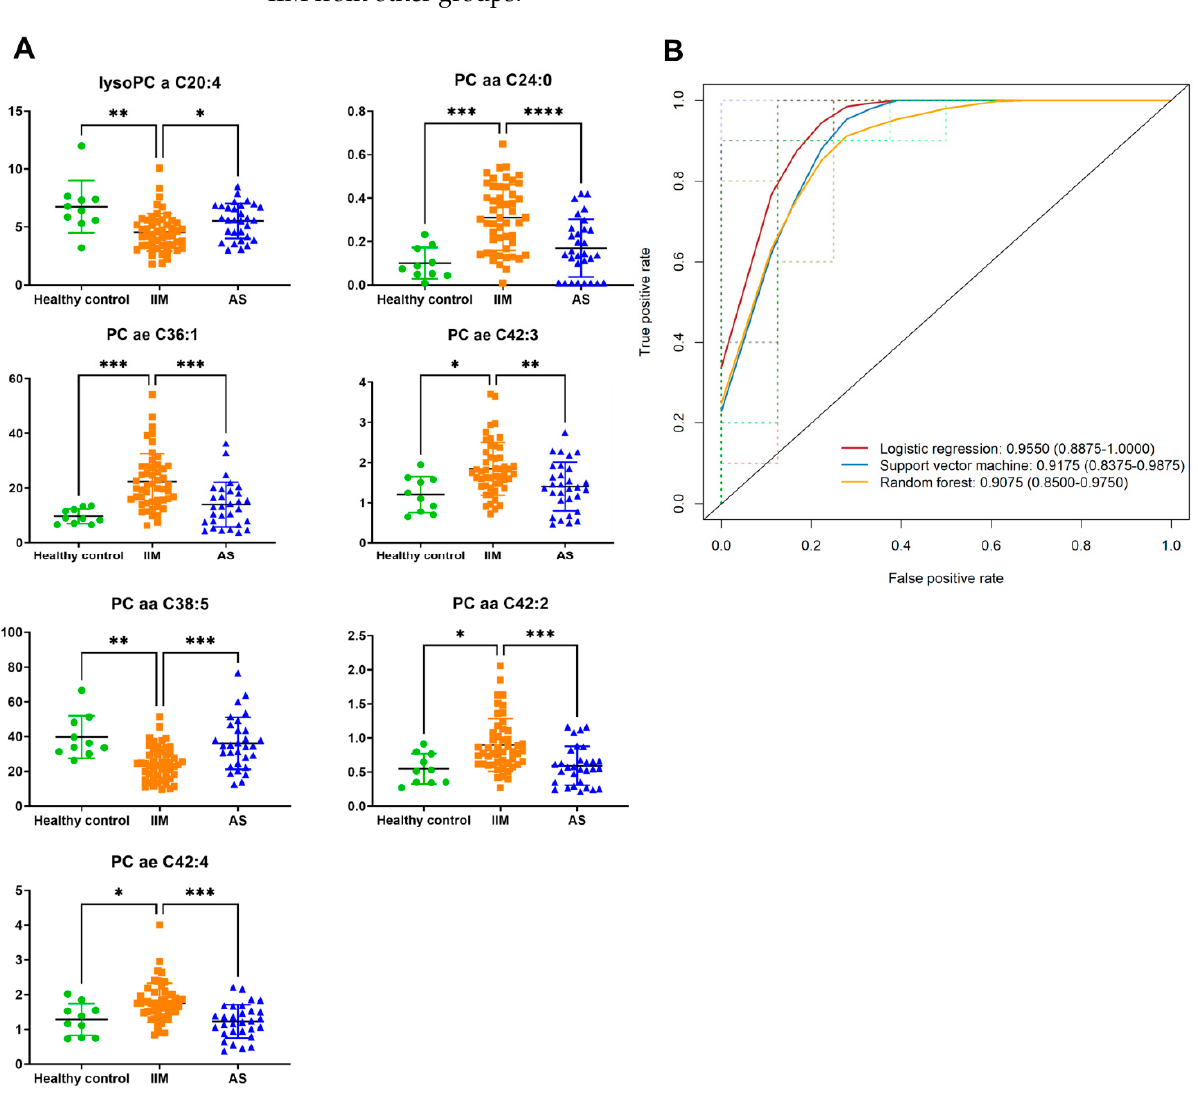
color: red indicates up-regulation in IIM, and blue indicates down-regulation in IIM. Node size in- dicates the FDR-adjusted p -value.